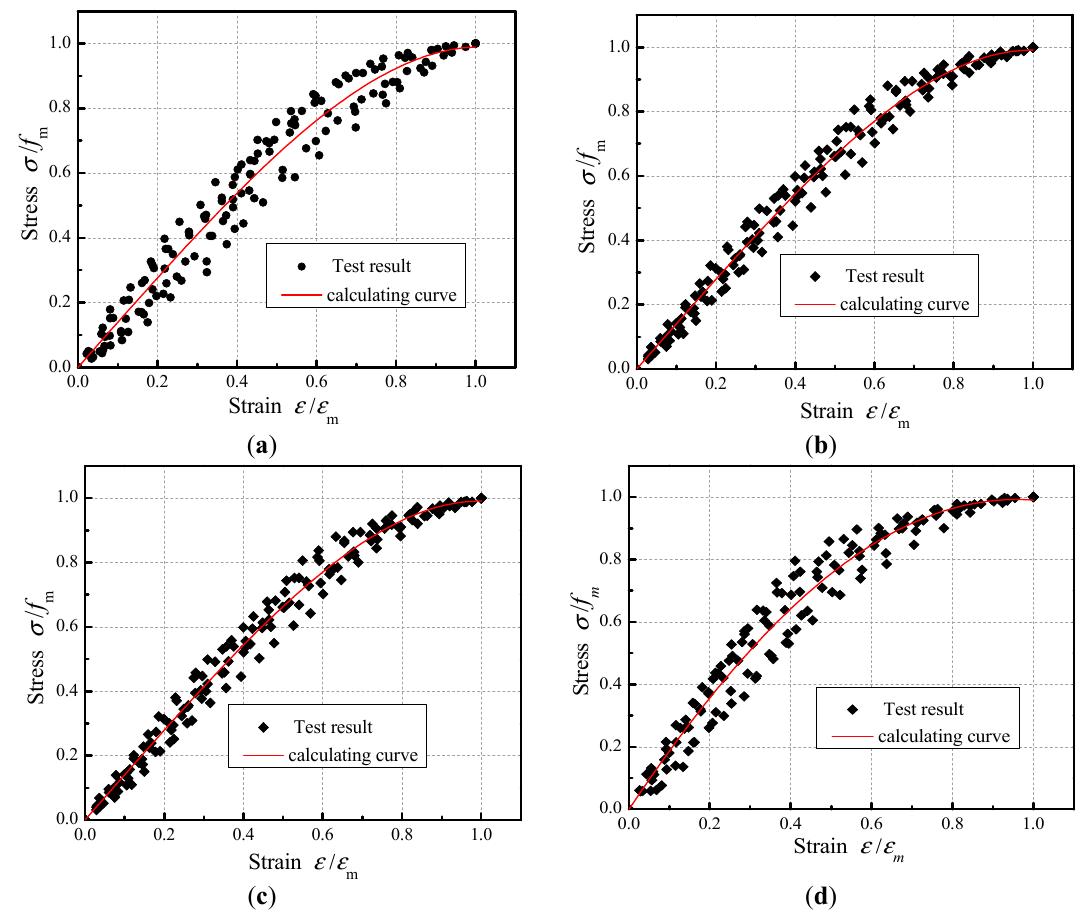
Figure 14. Fitting curves of stress-strain under di ff erent acid rain corrosion cycles. ( a ) 0 cycle, ( b ) 100 cycles, ( c ) 200 cycles, and ( d ) 300 cycles.